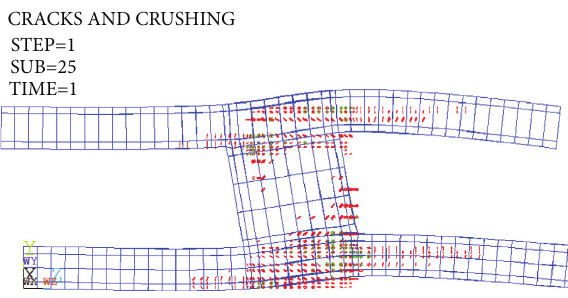
Figure 28: Cracks and crushing of concrete.